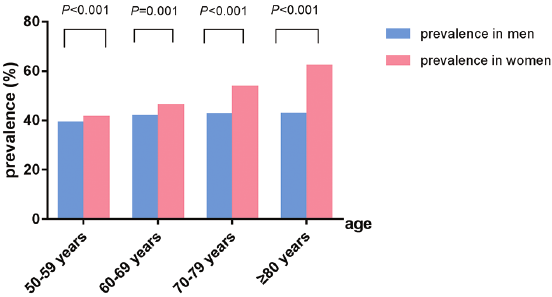
Figure 2. Prevalence of OA in Chinese adults aged 50 years or older classified by